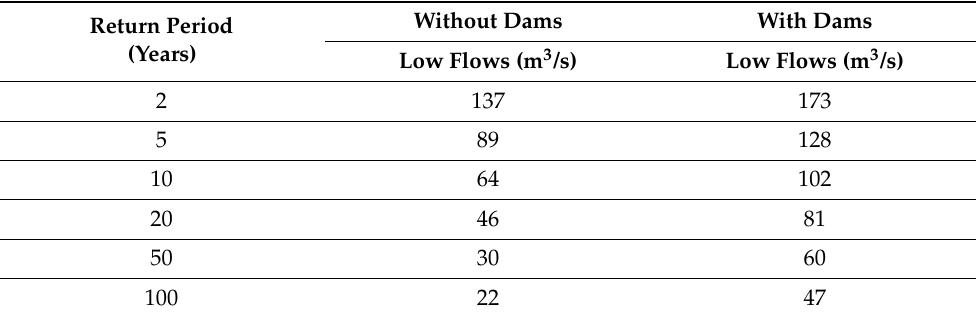
Table 6. Seven-day average low flow statistics with and without the proposed new large dams.